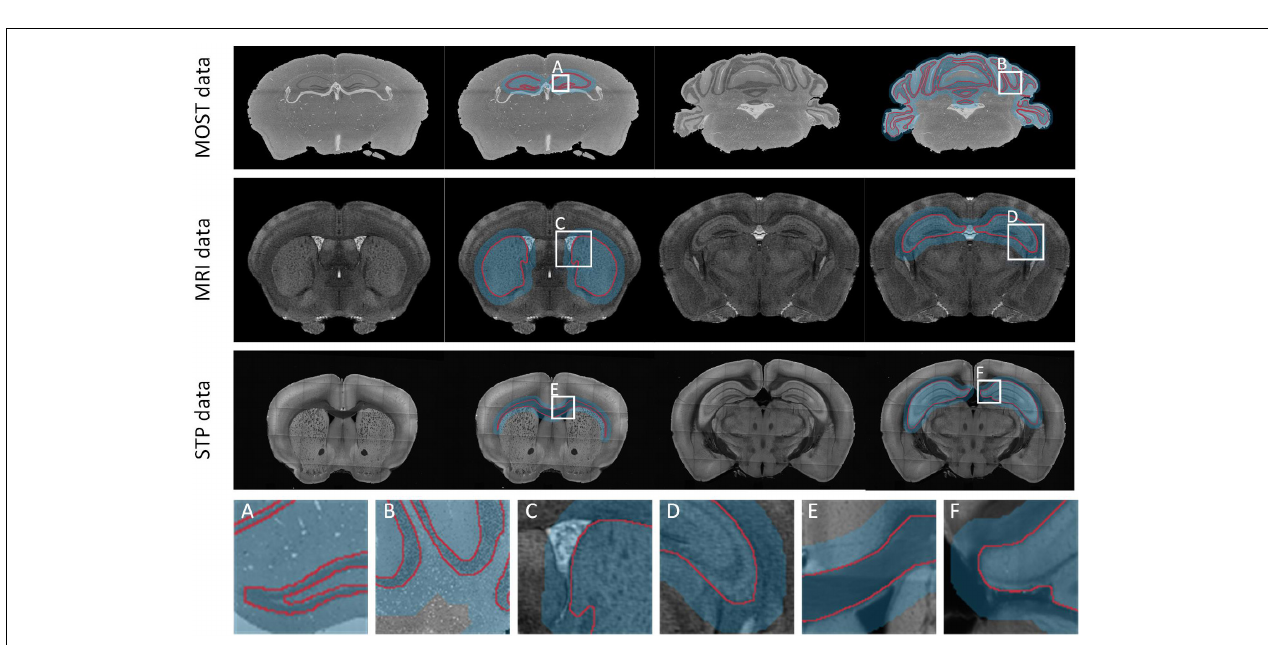
FIGURE 8 | Applicability of DeepBrainSeg for other types of datasets. The first row shows the segmentation effects of HIP-pg and CBX-gl for MOST data. From left to right: the coronal image, the superposition of image, the localization masks, and the segmented lines for HIP-pg and CBX-gl. The second and third rows show CP and HIP for the MRI data, CC, and HIP for STP data, respectively. (A–F) Enlarged views of the areas in white boxes in the first three rows.